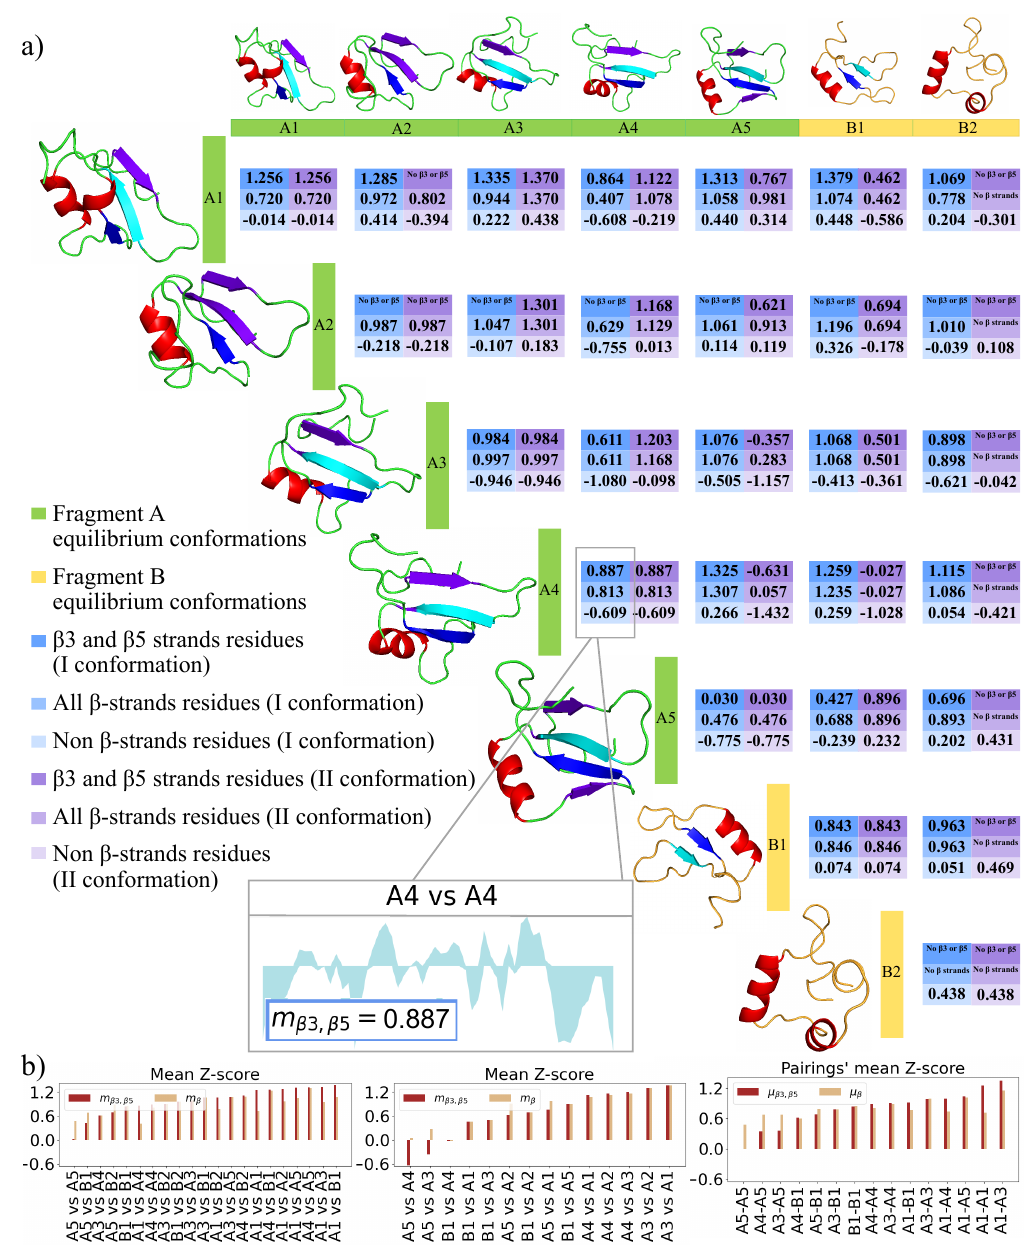
Figure 4. Analysis of the shape complementarity between the sampled MD conformations. ( a ) Comparison between all possible pairings of the five extracted conformations for Fragment A (green labels) and the two extracted conformations for Fragment B (yellow labels). For all possible pairings between conformations, we compute the BP of the residues of both surfaces and report the mean of the Binding Propensity (PB) Z-score of the residues that are part of the β 3 and β 5 strands ( m β 3, β 5 , in dark blue for the first surface in the pairing and in dark purple for the second one), of all the β -strands ( m β , in blue for the first surface and in purple for the second) and of the residues that are not part of β -strands ( m r , in light blue for the first surface and light purple for the second). An example of a Z-score profile for all the residues of conformation A4 compared with itself is shown in the zoom. Cartoon representations of the Fragments’ conformations are shown in correspondence with the reported scores. For each conformation, the β 3 and β 5 residues are colored in cyan or blue, respectively. The remaining β residues are marked in purple, while the α residues are colored in red. ( b ) From left to right, bar plots representation of the m β 3, β 5 and m β values computed for the first conformation in each pairing of ( a ), for the second, and means ( µ β 3, β 5 , µ β ), over the two conformations. The pairings are ordered from left to right according to increasing µ β 3, β 5